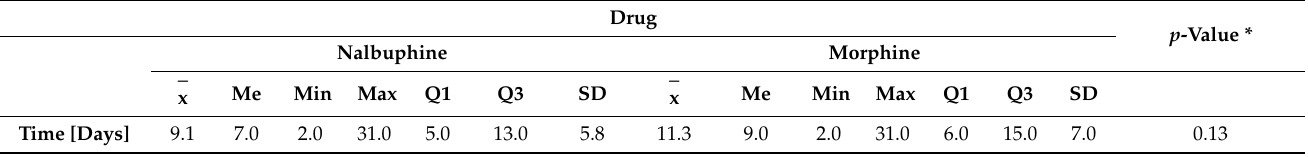
Table 1. A Comparison of therapy period depending on the drug used.